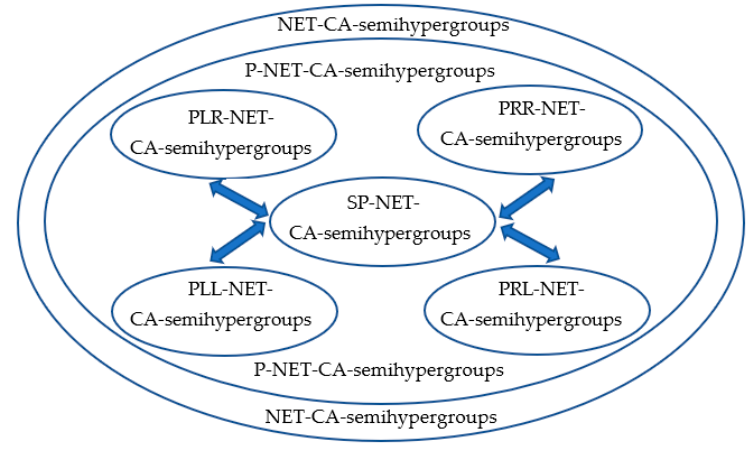
Figure 15. The relations among various P-NET-CA-semihypergroups. Based on the research in this paper, we will also focus on the research of nonassociative algebra, such as hyperideals of CA-semihypergroups, CA-semihypergroup homomorphisms, simple CA-semihypergroups, ordered CA-semihypergroups, and so on in the future.